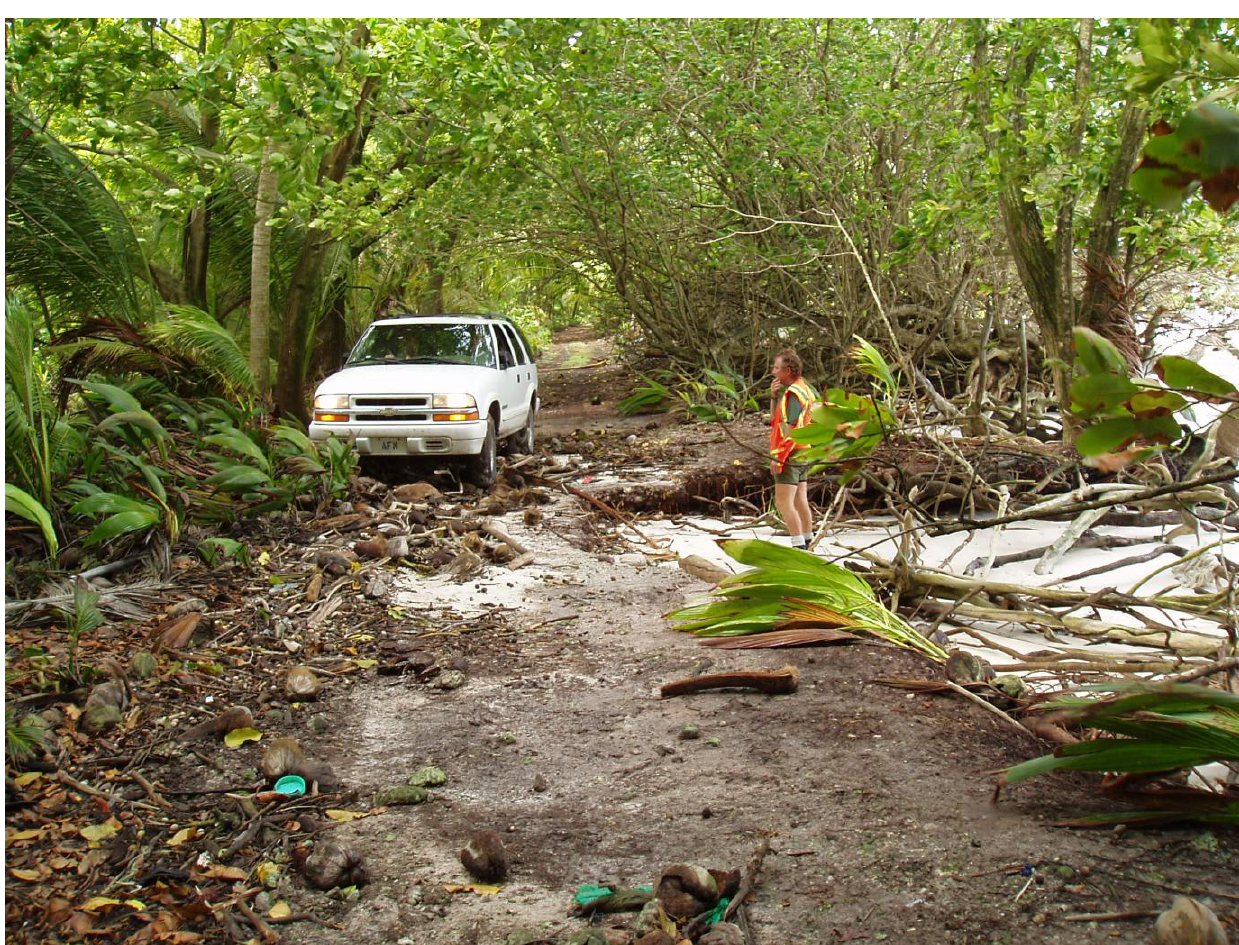
Figure 3. Erosion on a sheltered, lagoonal facing shoreline. The erosion is of mature, dark soil, not transient white sand